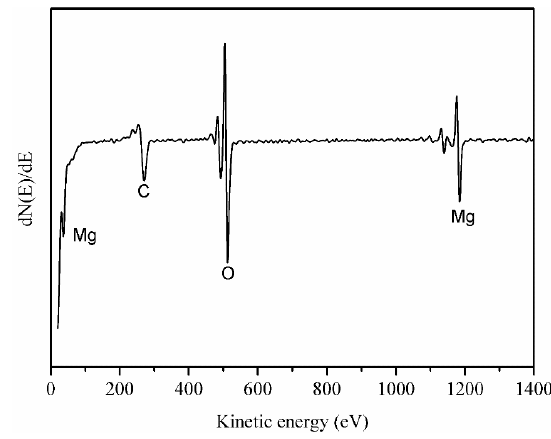
Figure 3. Surface Auger electron spectroscopy (AES) spectrum of the Ag-2Mg-2Al alloy activated at 600 °C for 30 min at an oxygen pressure of 15.0 Pa.